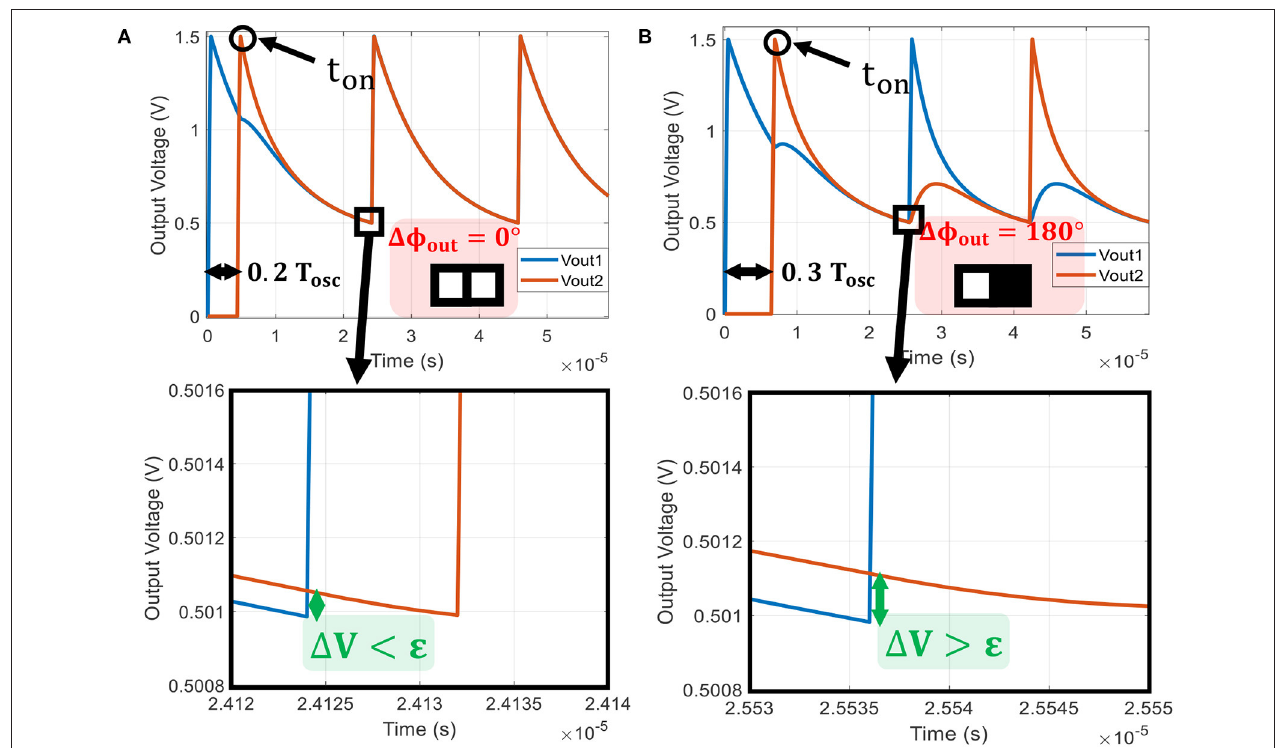
FIGURE 6 | Two identical oscillators coupled by R C = 12k (cid:127) . (A) The second oscillator is turned on at 0.2 T osc after the first one. By zooming on the waveform when the first oscillator reaches V − , we observe a voltage difference 1 V < ǫ . Therefore, the oscillators converge to an in-phase state. (B) The second oscillator is turned-on 0.3 T osc after the first one. In this case, we observe a voltage difference 1 V > ǫ and the oscillators converge to an out-of-phase state.